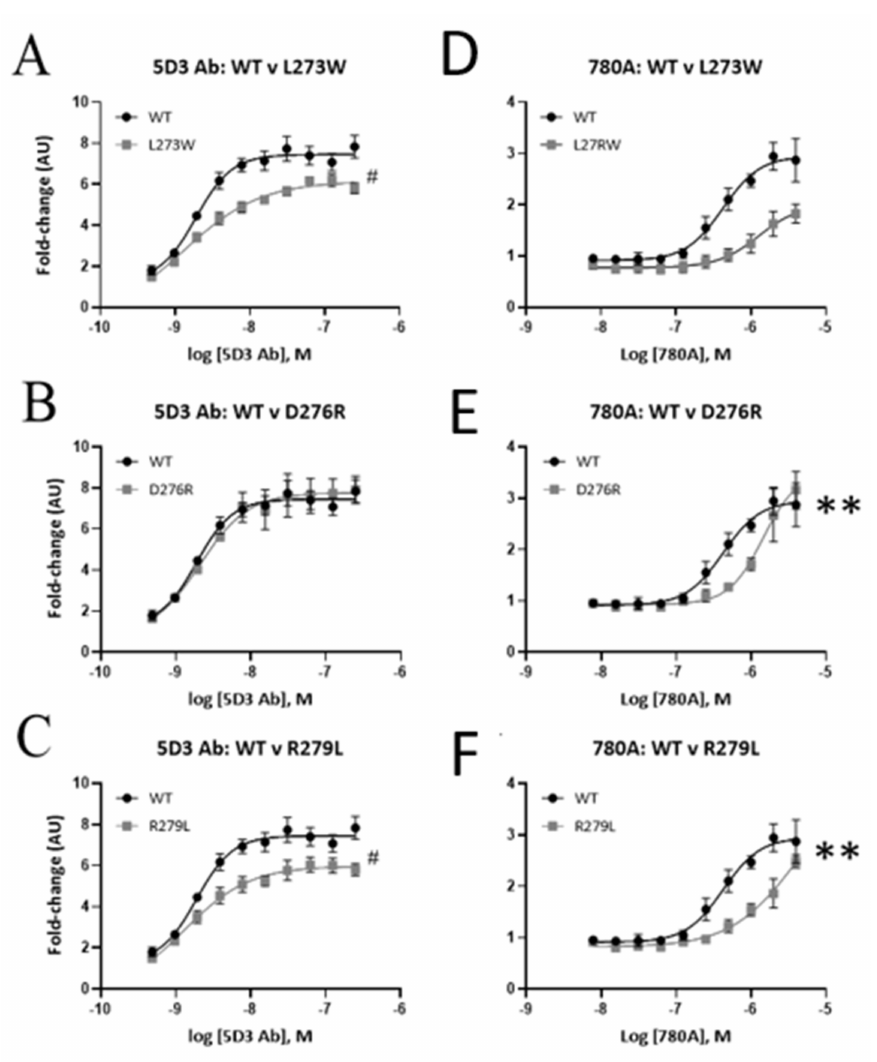
Figure 8. Comparison of the relative binding affinities of Affimer 780A to mAb 5D3 to recombinant EPAC1 ∆ DEP WT and mutant proteins. GST-tagged recombinant (wild-type (WT) or mutant) protein were added to glutathione-coated plates and incubated overnight at 4 ◦ C. Serial dilutions of antibody ( A – C ) mAb 5D3 (0.2–125 nM) and ( D – F ) Affimer 780A (0.004–4 µ M) and incubated for one hour at RT. Anti-His-tag or anti-mouse antibodies (1:10,000) were then added and incubated for a further one hour at RT. The ELISA substrate was then added, and absorbance measurements (655 nm) were taken after 30 min incubation at RT using a FLUOstar Omega Microplate reader. Data are normalized as a fold change with the relative fluorescence associated with the lowest concentration of antibody or Affimer set to 1 (arbitrary units (AU)). Error bars represent standard error of the mean ( n = 3–5). Significant increases in EC50 (** p < 0.005) or decrease in Emax ( # p < 0.05) relative to EPAC1 ∆ DEP WT were determined by unpaired t -test (GraphPad Prism). ( F ) Competition ELISA assays to check overlap between Affimer 780A and antibody 5D3 binding sites. Affinity reagents were used at concentrations on 145 nM and 2 nM,